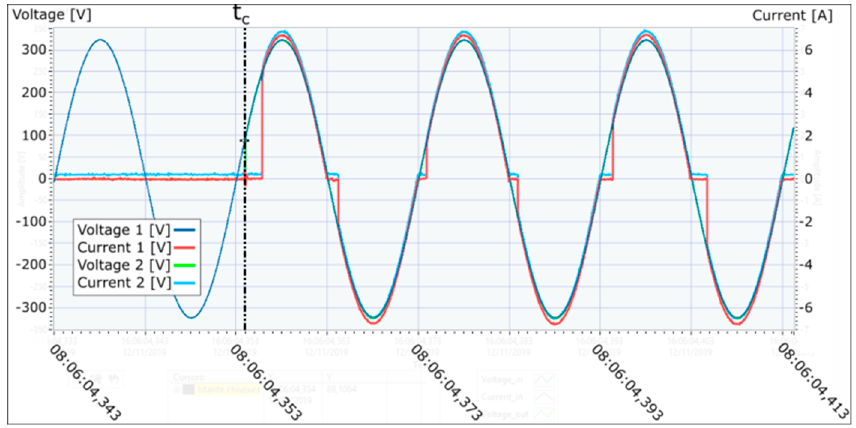
Figure 16. Instant ( t c ) at which the arc was formed (using the Bourns 2049-23 surge arrester).